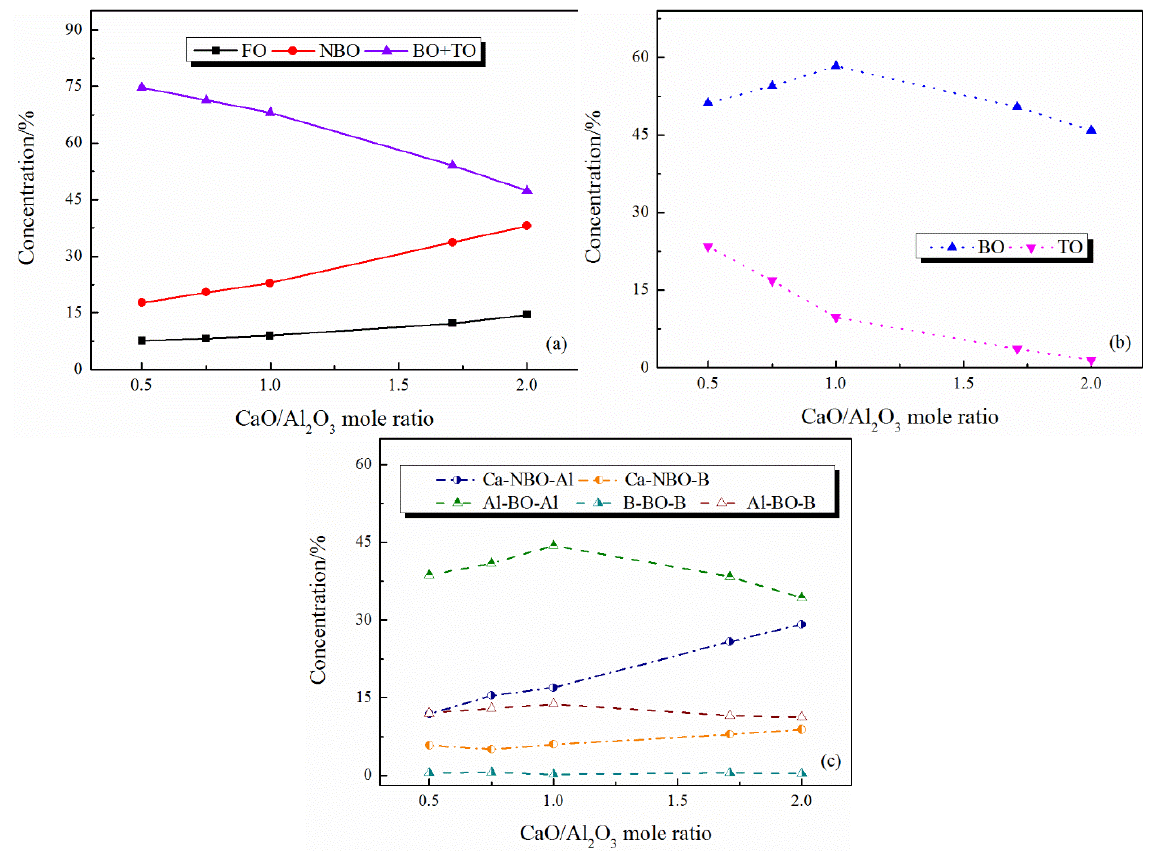
Figure 3. Distribution of oxygen types in CaO – Al 2 O 3 melts with different CaO/Al 2 O 3 mole ratios: ( a ) the initial distribution; ( b ) the refined distribution of networked structural oxygen.